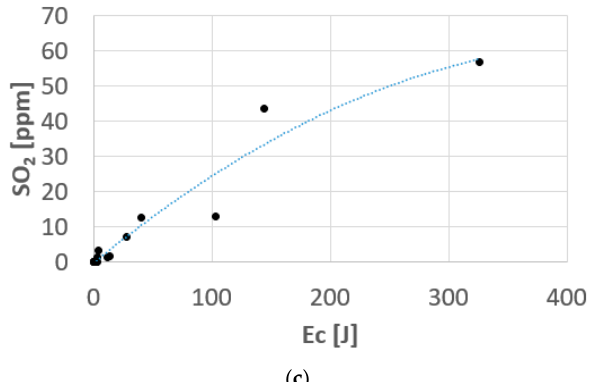
Figure 8. Increasing trends of decomposed gases according to the cumulative partial discharge energy. ( a ) SO 2 F 2 , ( b ) SOF 2 , ( c ) SO 2 .